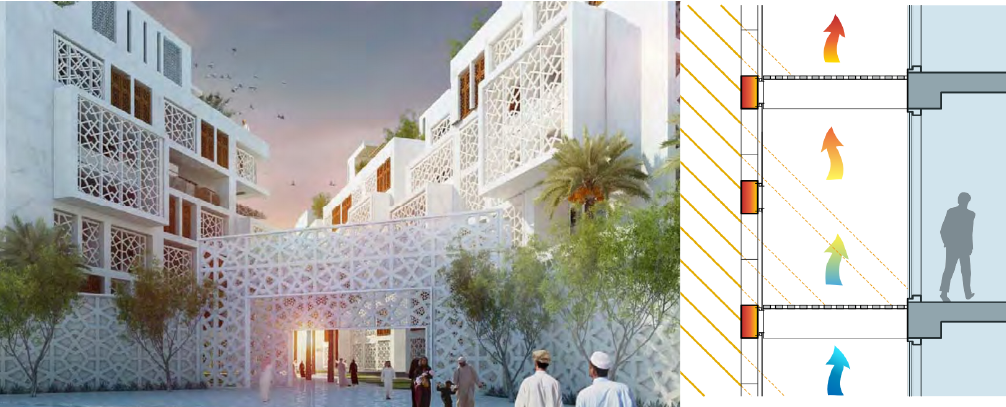
Figure 9. The modern use of Mashrabiya in the Muttawar multifamily housing project in Muscat